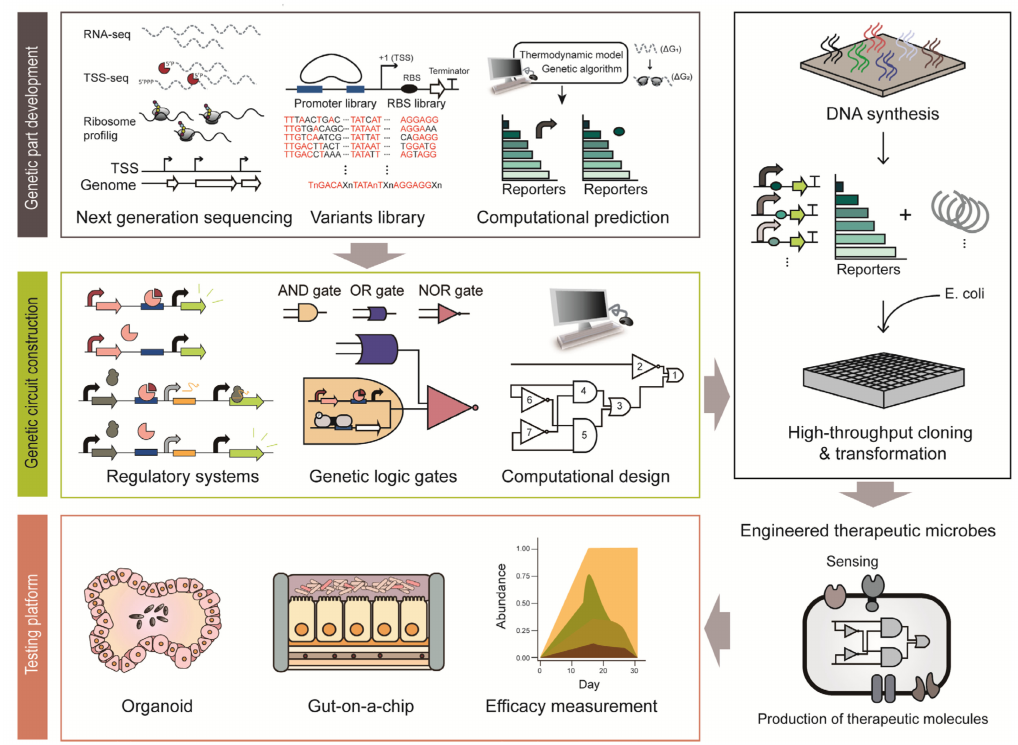
Figure 2. Illustration of the process employed to construct engineered therapeutic microbes based synthetic biology